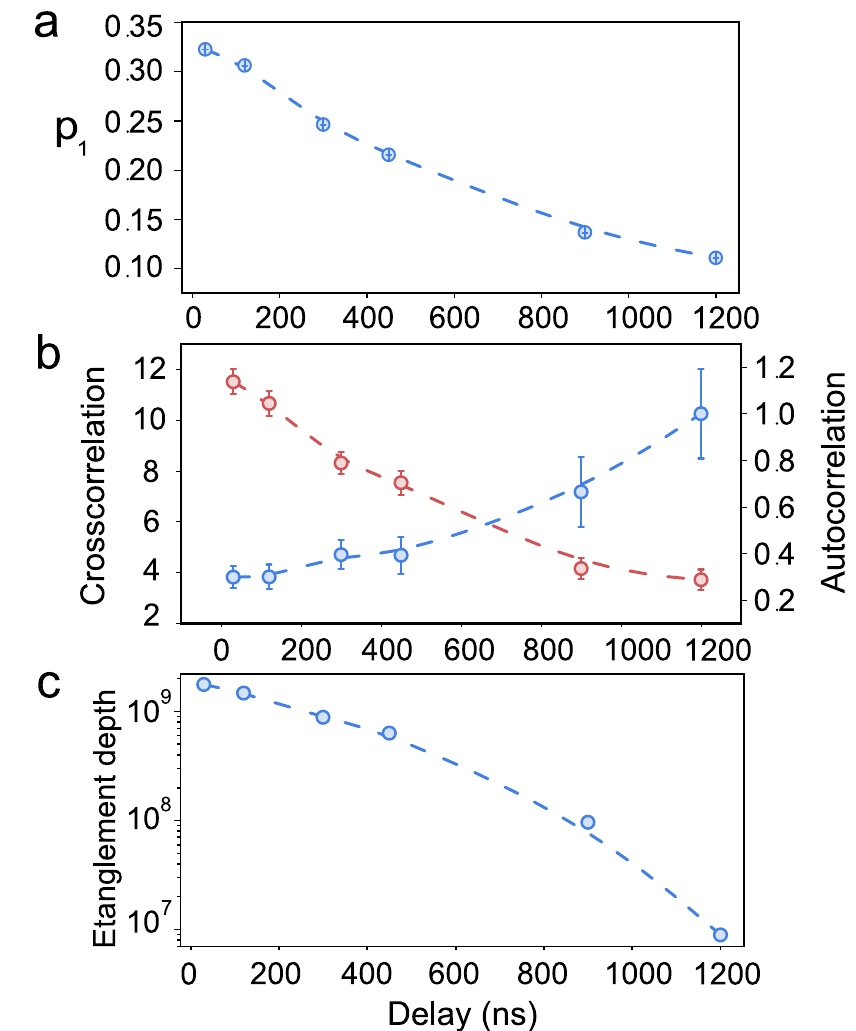
Fig. 3 Decoherence of the multipartite entanglement. a The variation of p 1 probabilities. b The cross-correlation g ð 2 Þ Stokes and anti-Stokes photons is on the left side (as pink dots show); the autocorrelation g ð 2 Þ heralded by the Stokes photon is on the right side (as blue dots show), which approaches 1 as the storage time increases. Error bars are derived by the Poisson distribution of photon number statistics from avalanche photodiodes. c The evolution of entanglement depth varies with the storage time of quantum memory. According to the error bars of M values in Fig. 2, we can calculate the variance of evaluating the entanglement depth. The entanglement depth with the memory time from 30 – 1200 ns are 1 : 77 ; 1 : 47 ; 0 : 88 ; 0 : 63 ; 0 : 09 ; 0 : 009